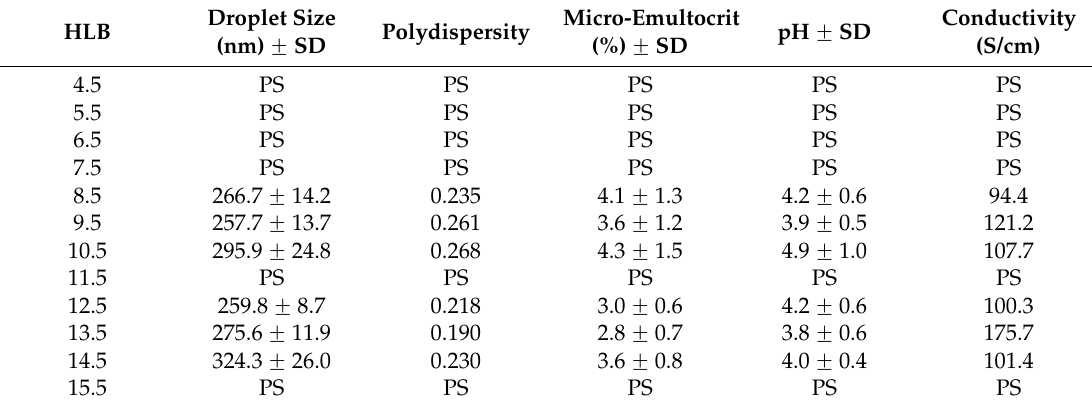
Table 2. Characterization of the first batch of nanoemulsion systems based on bullfrog oil to determine the HLBr after 60 days of evaluation at 25 ˝ C.